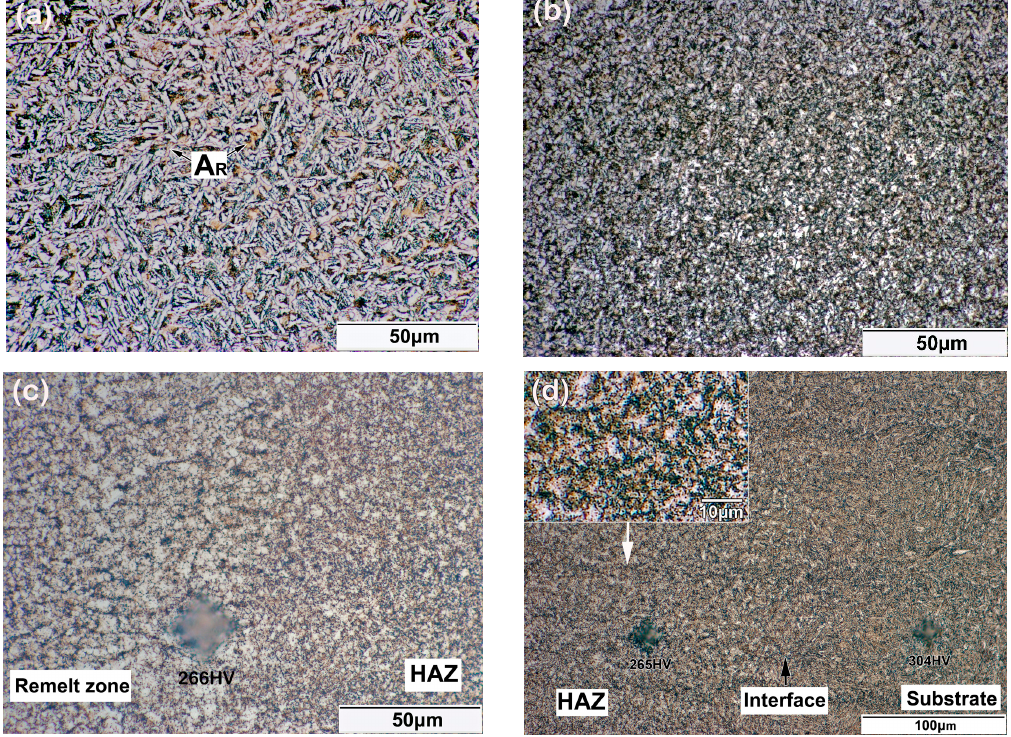
Figure 6. Microstructure of different areas in the 20-layer LFR sample: ( a ) top of the laser repaired layers; ( b ) bottom of the laser repaired layer; ( c ) the interface of the remelt zone and HAZ; and ( d ) the interface of HAZ and substrate.